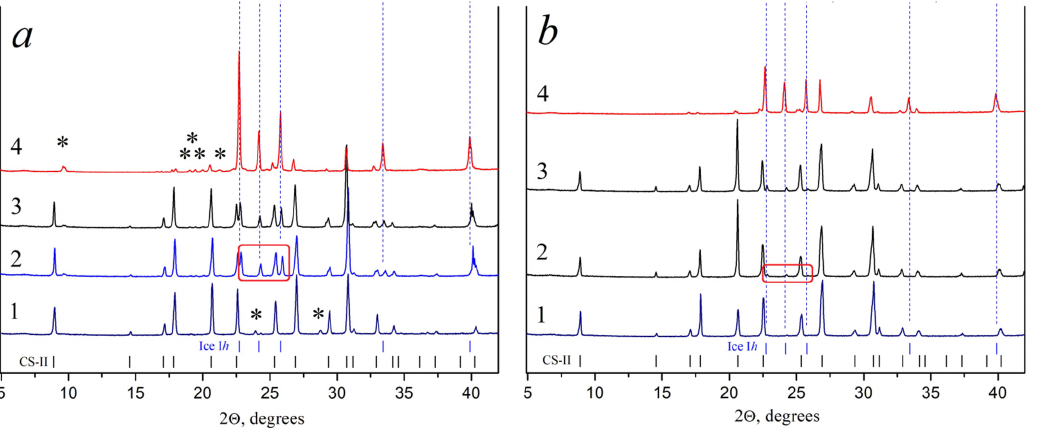
Figure 2. PXRD patterns for freezing solutions containing 5 wt % of excipient, 19.1 wt % of THF, and water in vials under different experimental conditions. The positions of the reflections of the CS-II THF hydrate and ice Ih are shown as ticks at the bottom. ( a ) (1) Phases formed on freezing a glycine solution at − 100 ◦ C; mannitol solution at − 100 ◦ C, − 10 ◦ C and ambient pressure (2, 3) and − 10 ◦ C/100 mTorr (4), respectively. ( b ) Phases formed on freezing a trehalose solution at − 100 ◦ C, − 50 ◦ C, − 10 ◦ C and ambient pressure (1, 2, 3) and − 10 ◦ C/100 mTorr (4), respectively. Asterisks—the strongest reflections of β -glycine and mannitol hemihydrate of the patterns “a1” and “a4”, respectively. The first reflections of ice Ih on patterns “a2” and “b2” are shown in a red rectangular